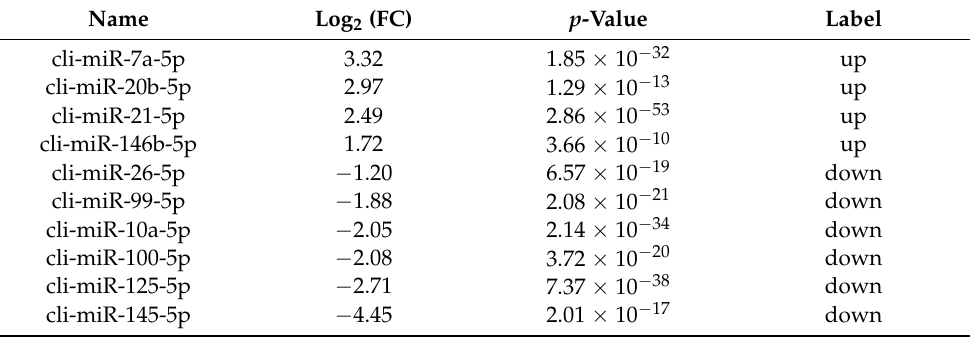
Table 2. Top 10 differentially expression miRNAs.